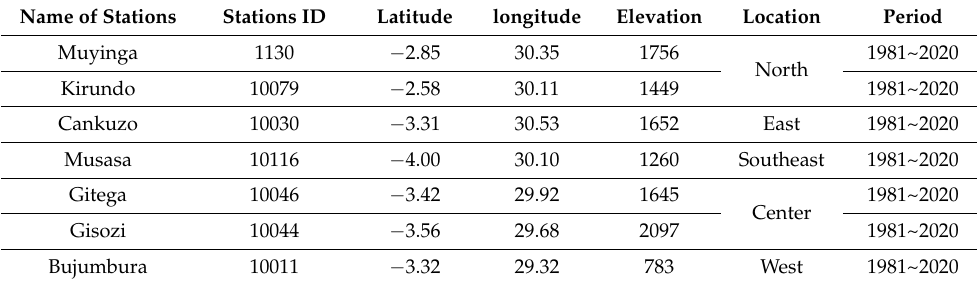
Table 1. Meteorological stations’ information and the record length of data used in this